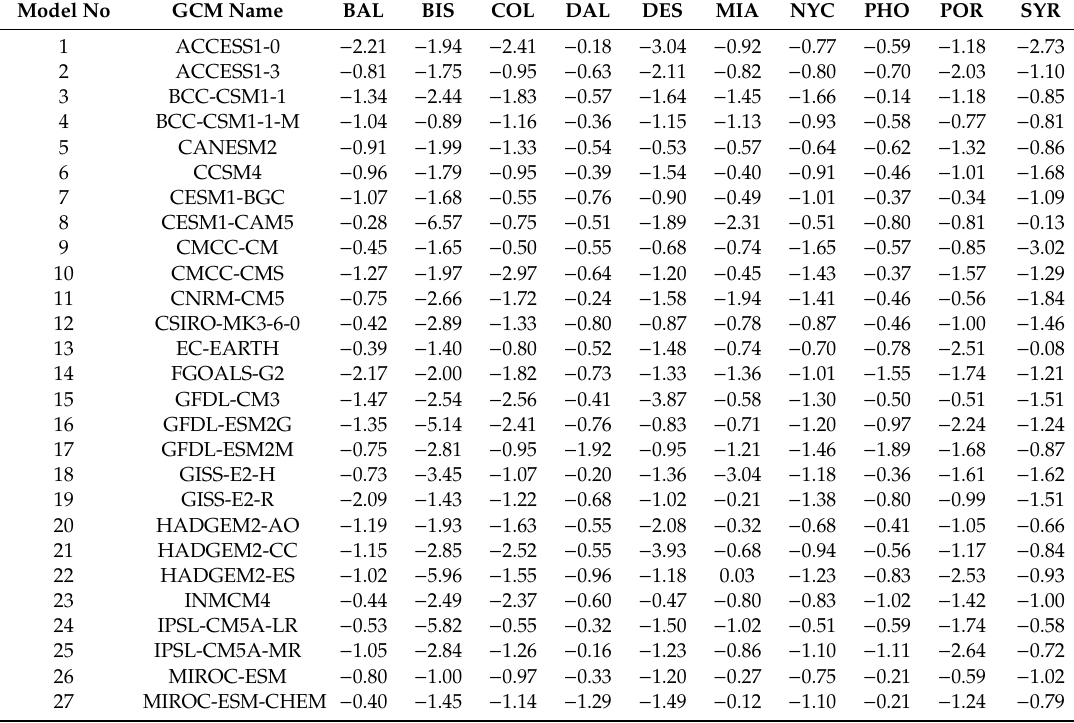
Table A8. NSE coe ffi cient of longest between observed and simulated data